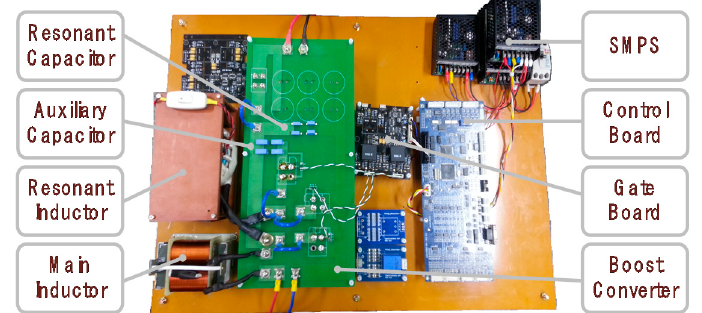
Figure 18. Experimental setup.